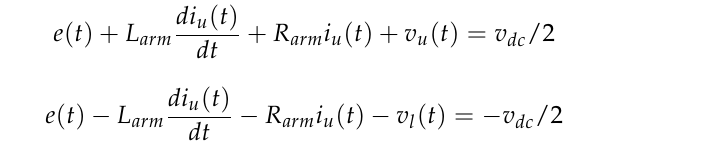
where v u ( t ) and v l ( t ) are the upper and lower arm voltage, e ( t ) is the point-of-common- coupling (PCC) voltage, and v dc is the DC-bus voltage. This paper adopts the time-averaged model of MMC, where the switching operations of the SMs are neglected and the SM capacitor voltages are assumed to be balanced [31]. Thus, the individual SMs dynamics in the arm can be neglected. Based on the averaged model, the arm voltages v u,l ( t ) and the sum capacitor voltages v